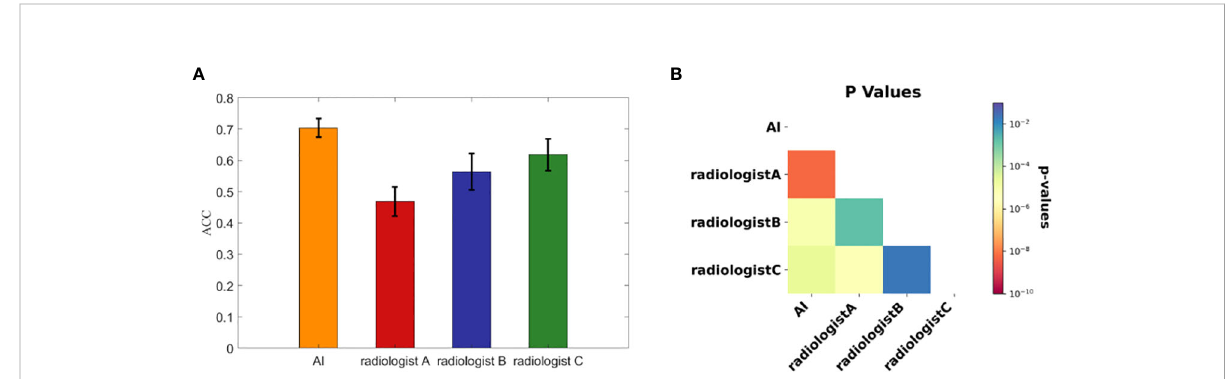
FIGURE 3 The diagnostic performances of three radiologists and the AI automatic diagnosis system. (A) The accuracies calculated from the ten subdivided datasets by the AI system and three radiologists. Each bar representing each concerned rater is presented with the average accuracy over the ten subdivided datasets and the standard deviation. (B) The associated p value matrix for statistical comparisons of diagnostic accuracies. All p values were <0.02 and self- comparisons were omitted as they were constant 1.